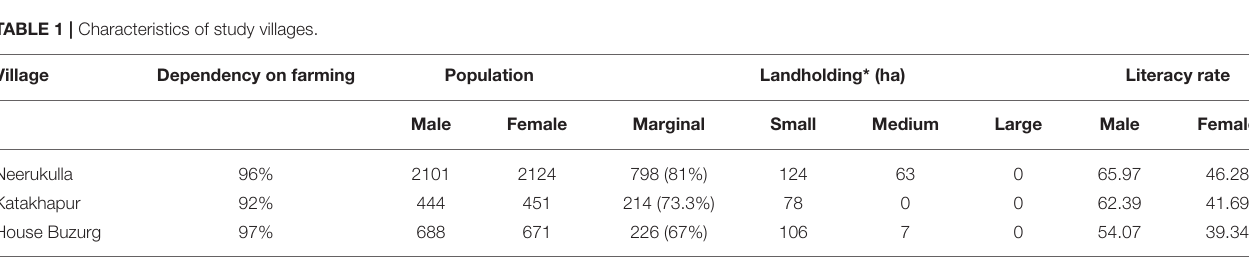
TABLE 1 | Characteristics of study